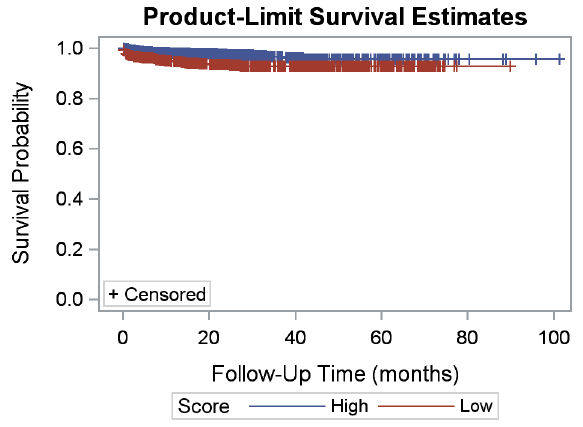
Figure 1. Kaplan-Meier survival by quality indicator score (high vs.